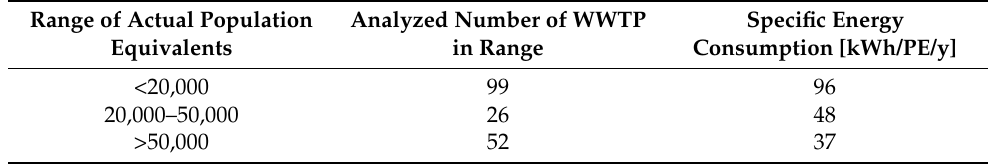
Table 1. Specific energy consumption in dependency of WWTP capacity in actual population